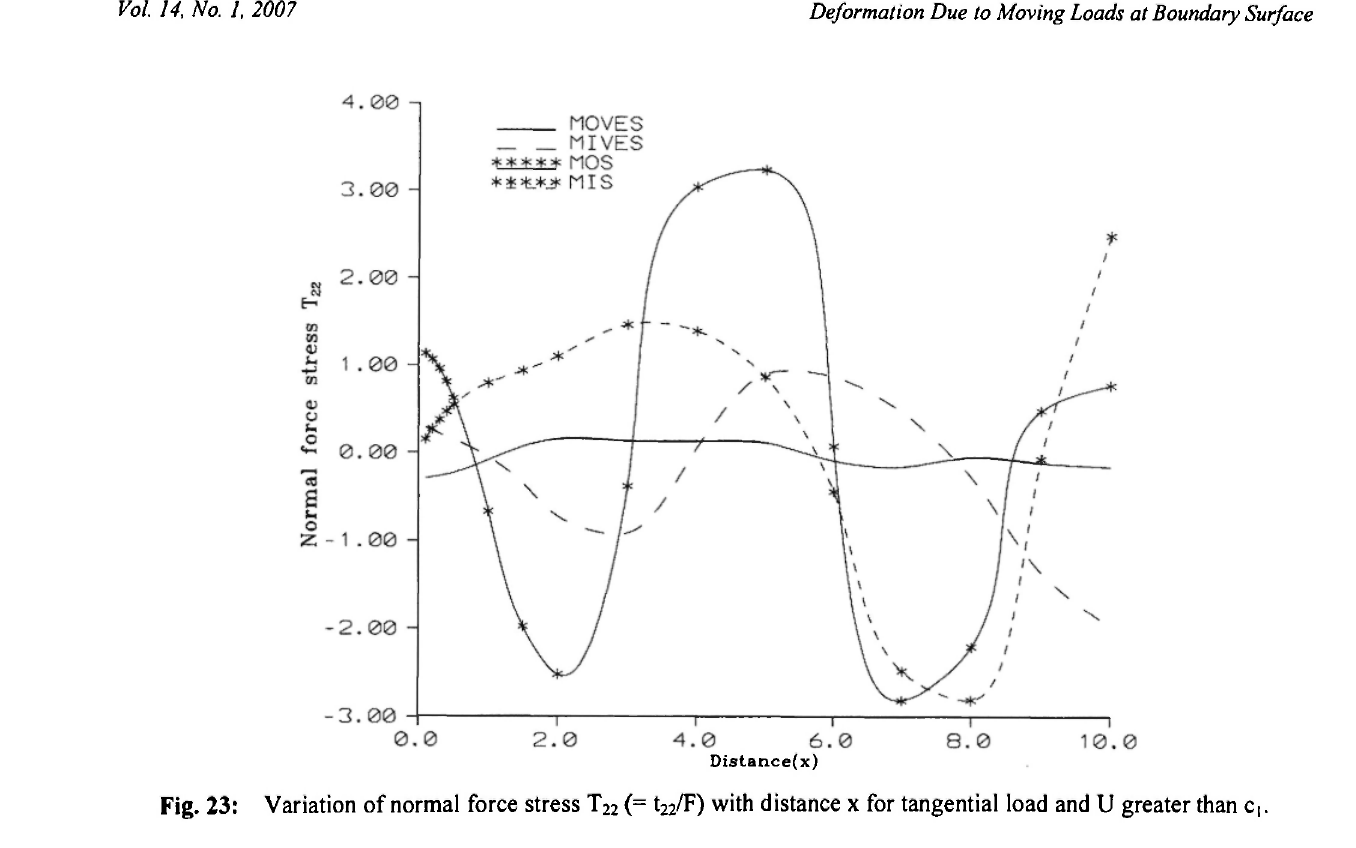
Fig. 23: Variation of normal force stress T 2 2 (= t^/F) with distance χ for tangential load and U greater than c : .